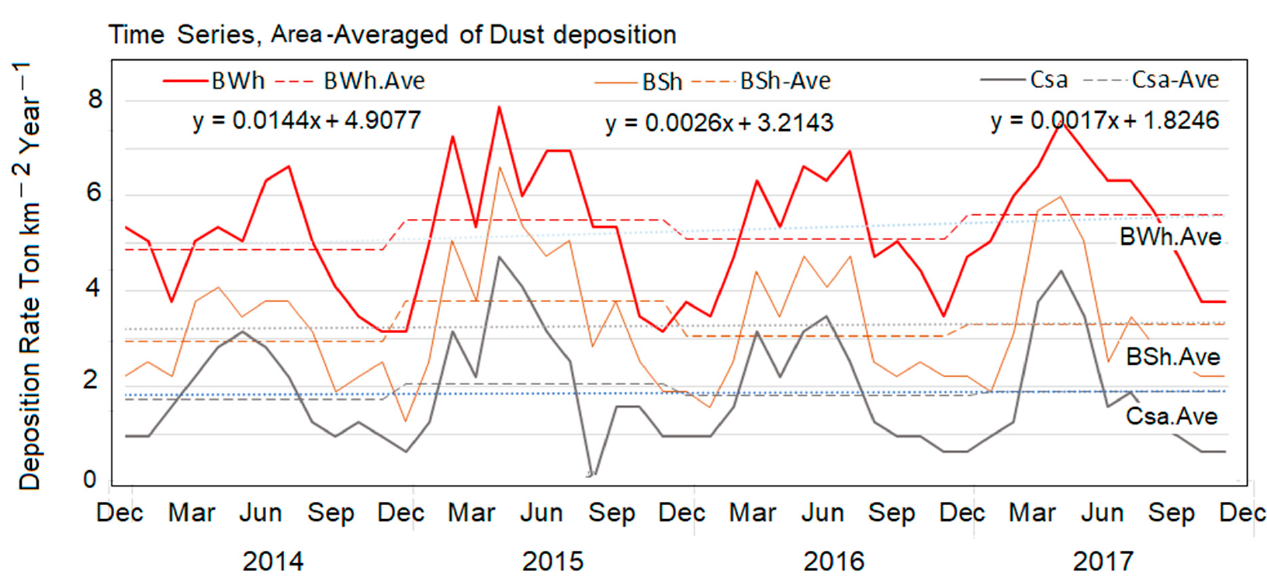
Figure 9. Monthly average deposition rates as determined by second modern-era retrospective analysis for research and applications (MERRA-II) model (M2TMNXAD4-V5.12.4). Solid lines in red, brown and gray are pronounced dry deposition rates in the different climate of BWh, BSh, and Csa respectively.